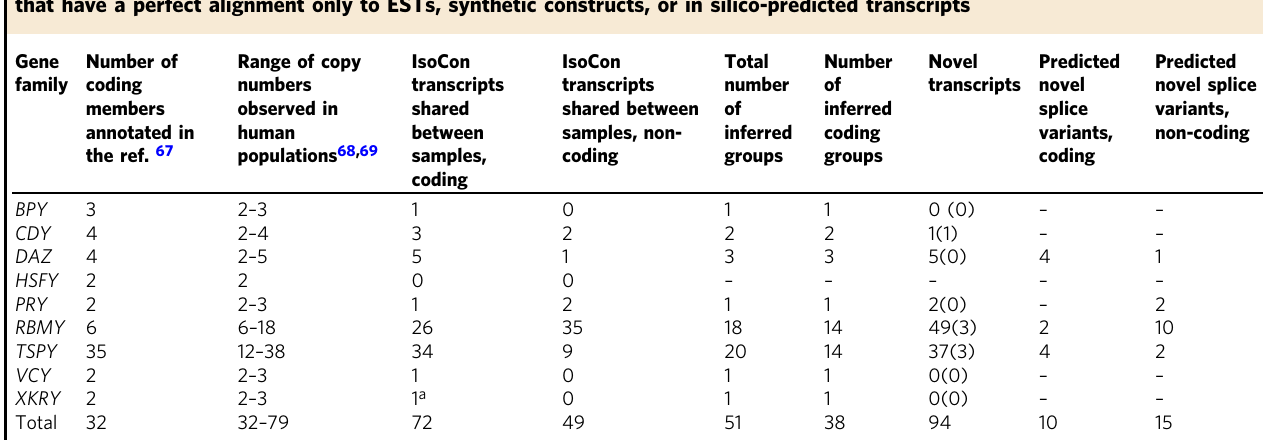
Table 3 IsoCon-predicted transcripts of the nine ampliconic gene families. Columns show predictions shared between samples, separated by gene family and categorized as coding or non-coding. The calculated number of groups is shown, in comparison to known copy numbers from the reference genome and observed in human populations. Novel transcripts are those that do not have a perfect alignment to the NCBI transcript reference database, the numbers in parentheses indicate additional transcripts that have a perfect alignment only to ESTs, synthetic constructs, or in silico-predicted